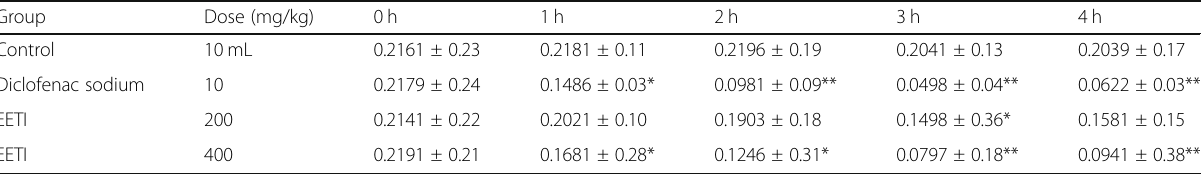
Table 4 Effect of EETI on carrageenan-induced paw edema test Group